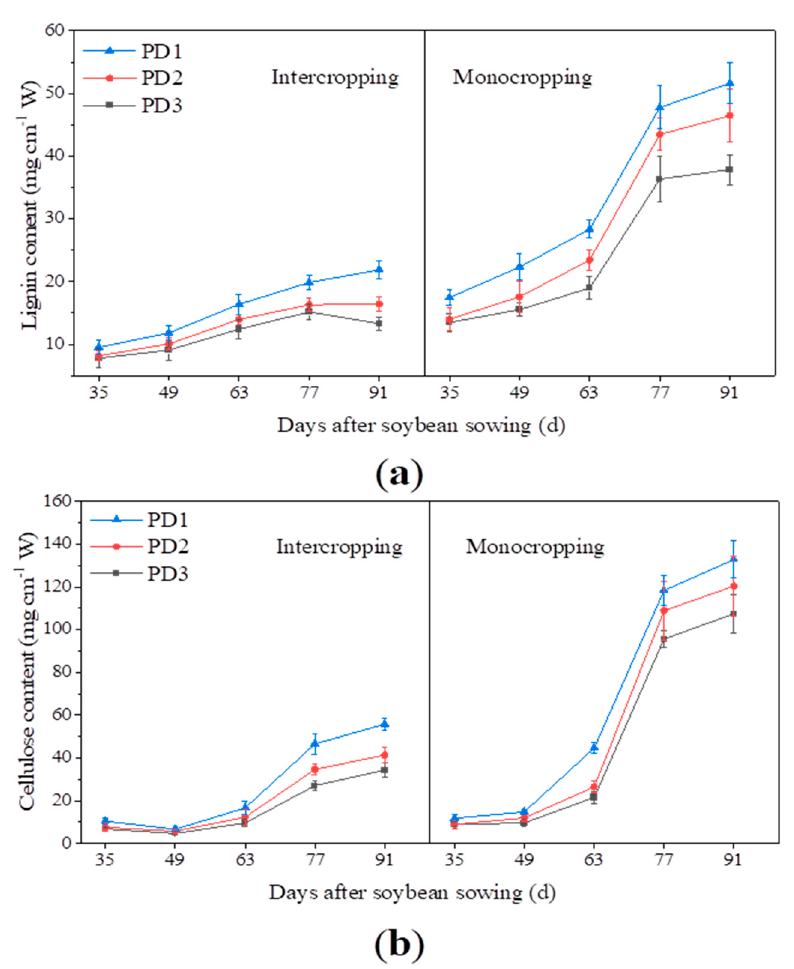
Figure 6. Effects of multiple planting densities (PD1 = 17, PD2 = 20, and PD3 = 25 plants m − 2 ) on lignin content ( a ) and cellulose content ( b ) under both strip intercropping system and monocropping. All the values are means (±SE) standard error of three replications.